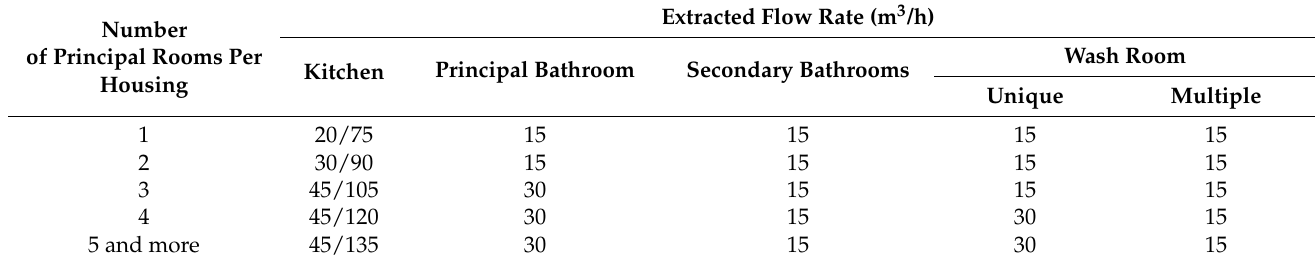
Table 3. Regulatory ventilation flow